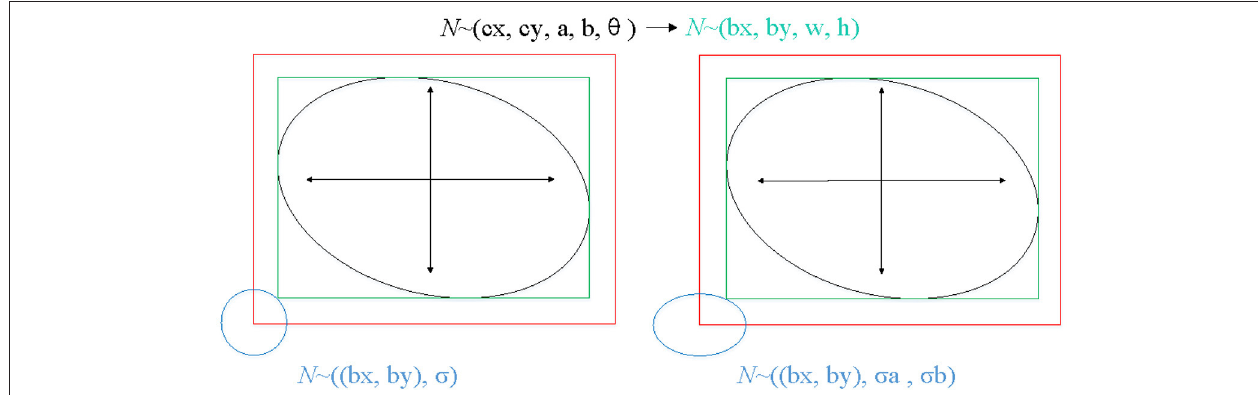
FIGURE 4 | The process of mapping GT of keypoints to a 2D Gaussian distribution on the heatmap. The left shows the mapping method of reference (28), the right shows the mapping method of ours.